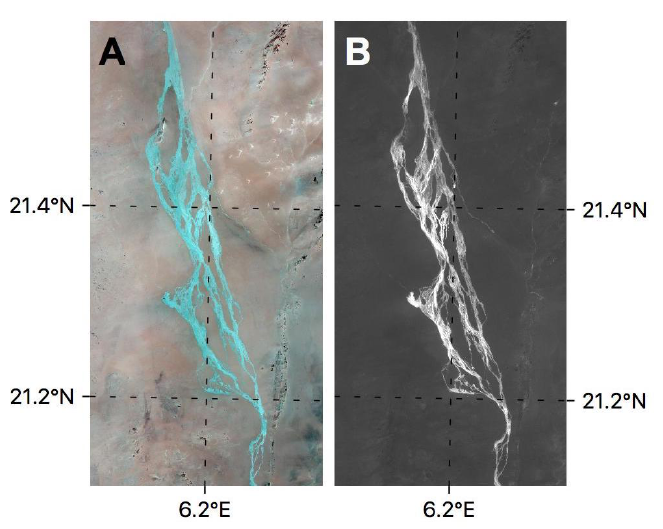
Figure 3. Example of a river bed in the study area on: ( A ) the Sentinel-2 false color RGB image created from bands 12, 7, and 4; and ( B ) the extracted H-band derived from the HLS transformation of the RGB